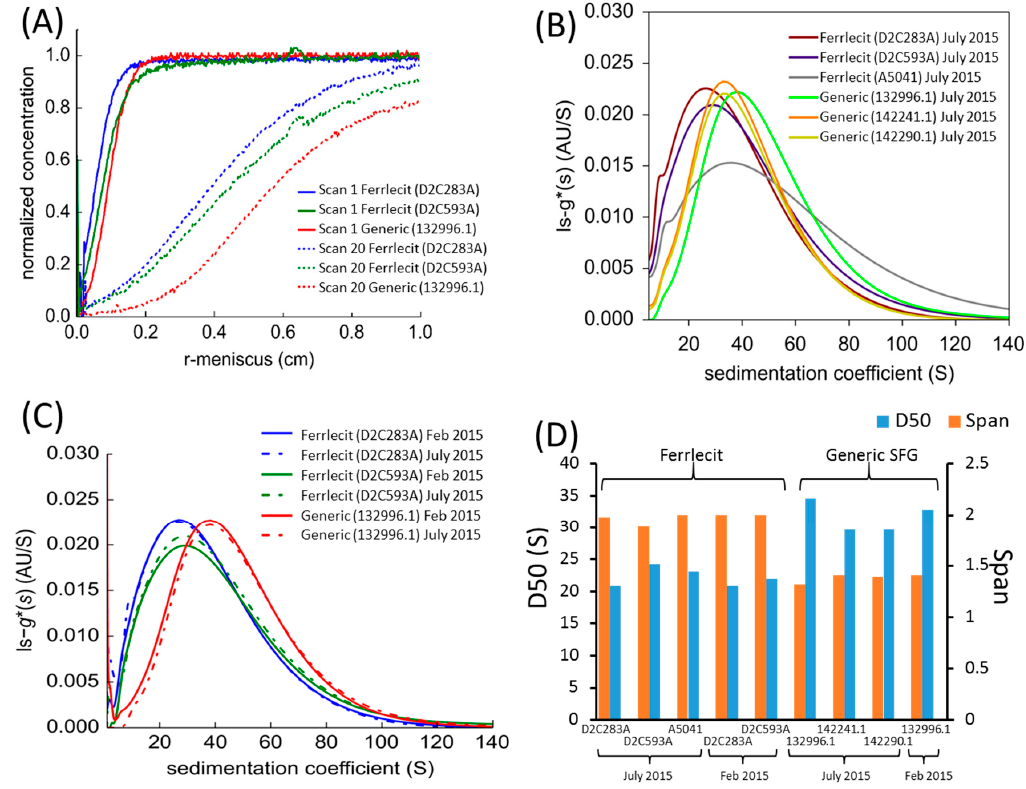
Figure 5. Sedimentation velocity analytical ultracentrifugation (SV-AUC) ( A ) raw data scans at 479 nm for Ferrlecit and generic SFG samples after 50-fold dilution with saline solution at 20,000 rpm. The first and twentieth scans thereafter are shown. ( B ) Normalized sedimentation coefficient distribution of Ferrlecit lots D2C283A, D2C593A and A5041 and generic SFG lots 132996.1, 142241.1 and 142290.1. ( C ) Normalized sedimentation coefficient distribution of two Ferrlecit lots D2C283A and D2C593A and one generic SFG lot 132996.1 at two time points, and ( D ) D50 and span comparison of normalized sedimentation coefficient distribution.